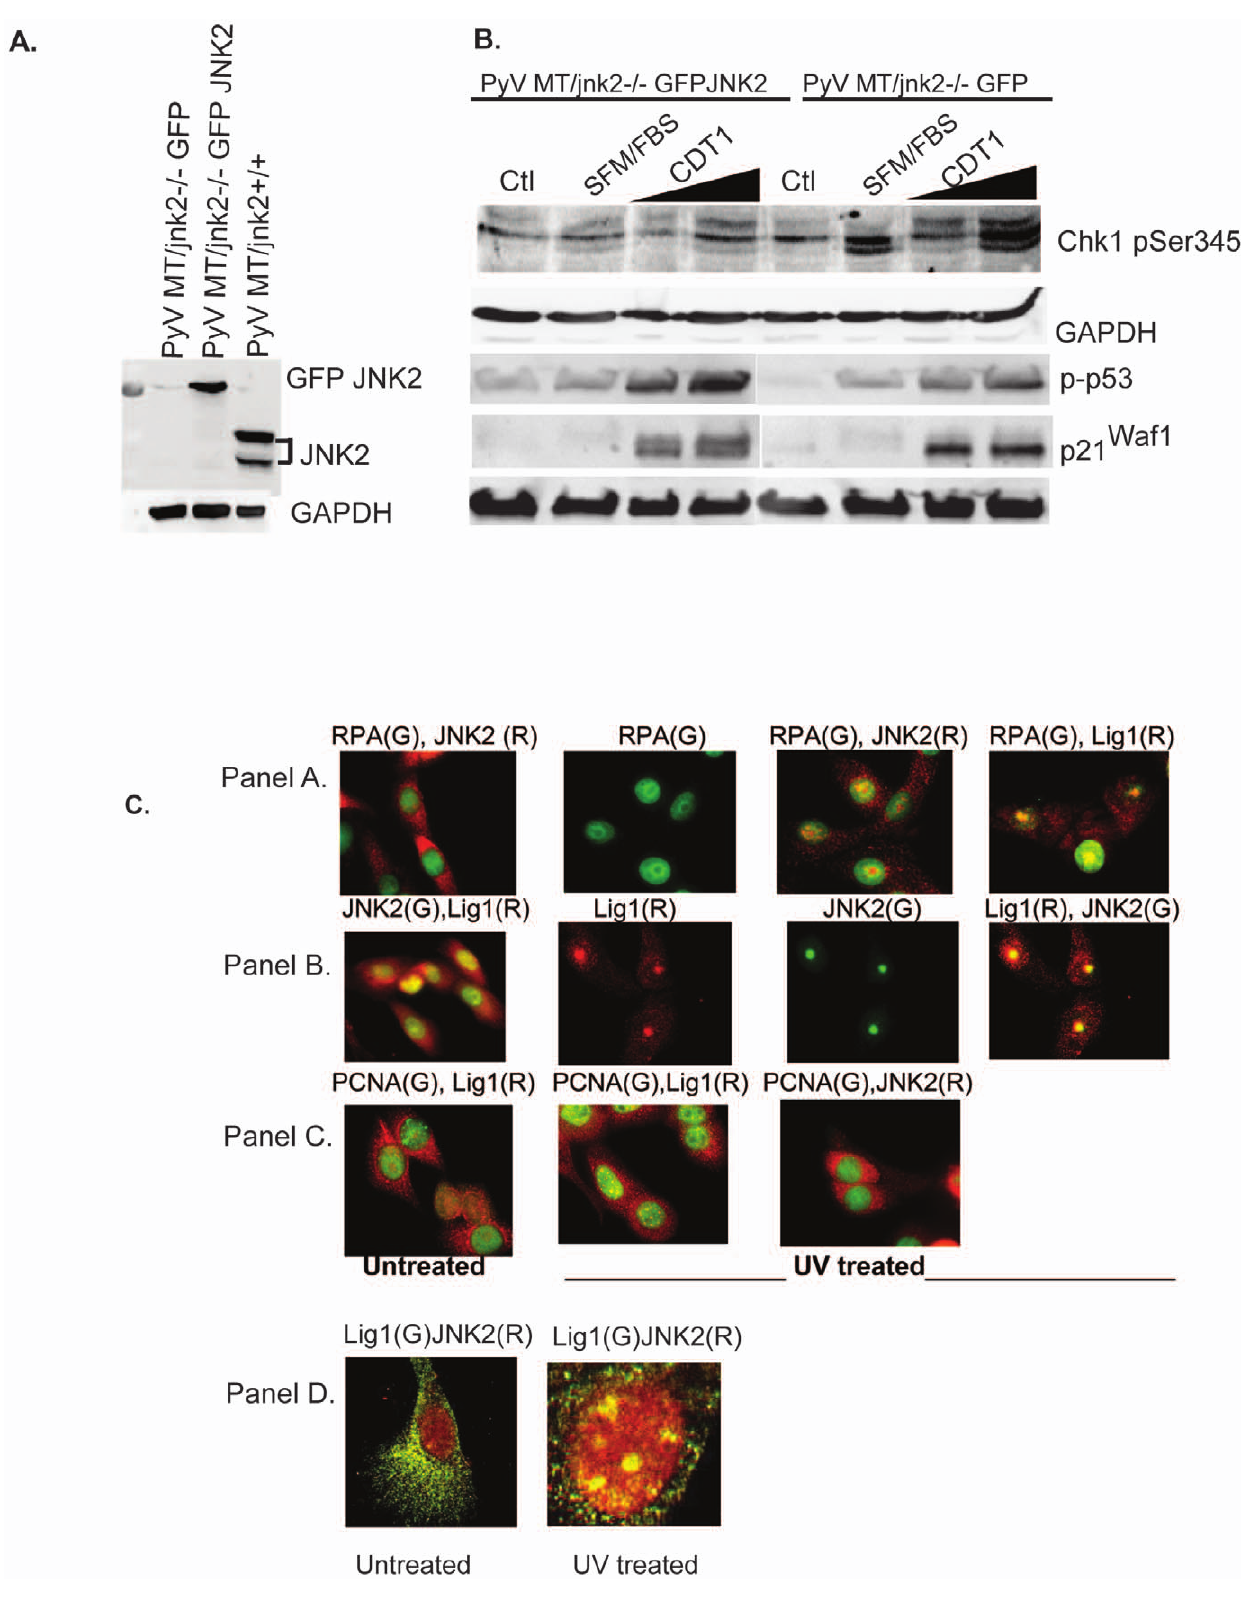
Figure 8. JNK2 is integral in sensing replicative stress and localizing at RPA coated lesions. A ). PyVMT/ jnk2 2 / 2 cells were infected with JNK2 a retrovirus and selected using puromycin. GFP-JNK2 expression was measured using JNK2 primary antibody and PyVMT/ jnk2 + / + lysates as positive a control; B ). PyVMT/ jnk2 2 / 2 and PyVMT/ jnk2 2 / 2 GFP-JNK2a expressing cells were infected with increasing doses of GFP-CDT1. Cells were processed as described in C). Cell lysates were analyzed for pChk1 (Ser 345), p53 (Ser 15) and p21 Waf1 . GAPDH was used to compare even sample